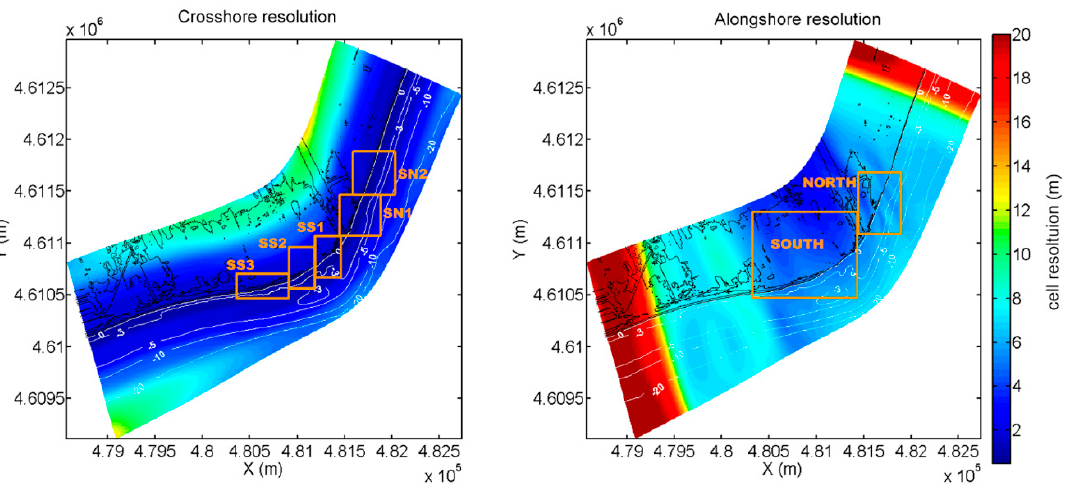
Figure 4. Distribution of cross-shore and alongshore grid resolution over the XBeach domain. Orange boxes show the location of post-processing subdomains, being SN and SS sectors ( left ) for the morpholodynamic analysis and NORTH, SOUTH sectors ( right ) for the inundation